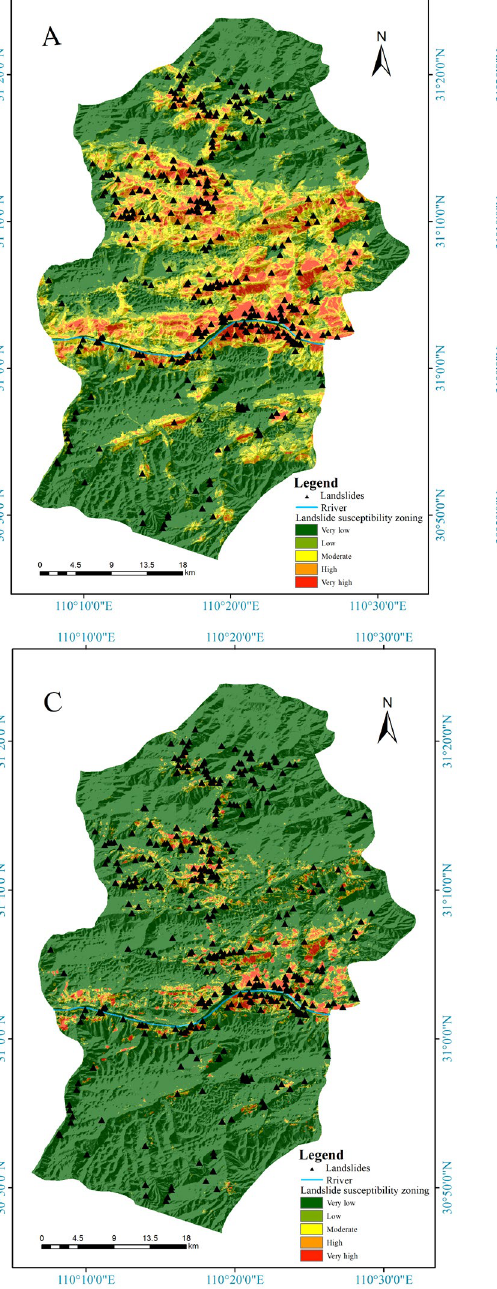
Figure 9. Landslide susceptibility zoning maps produced by three ensemble models: ( A ) RF model, ( B ) XGBoost model, and ( C ) gcForest model.